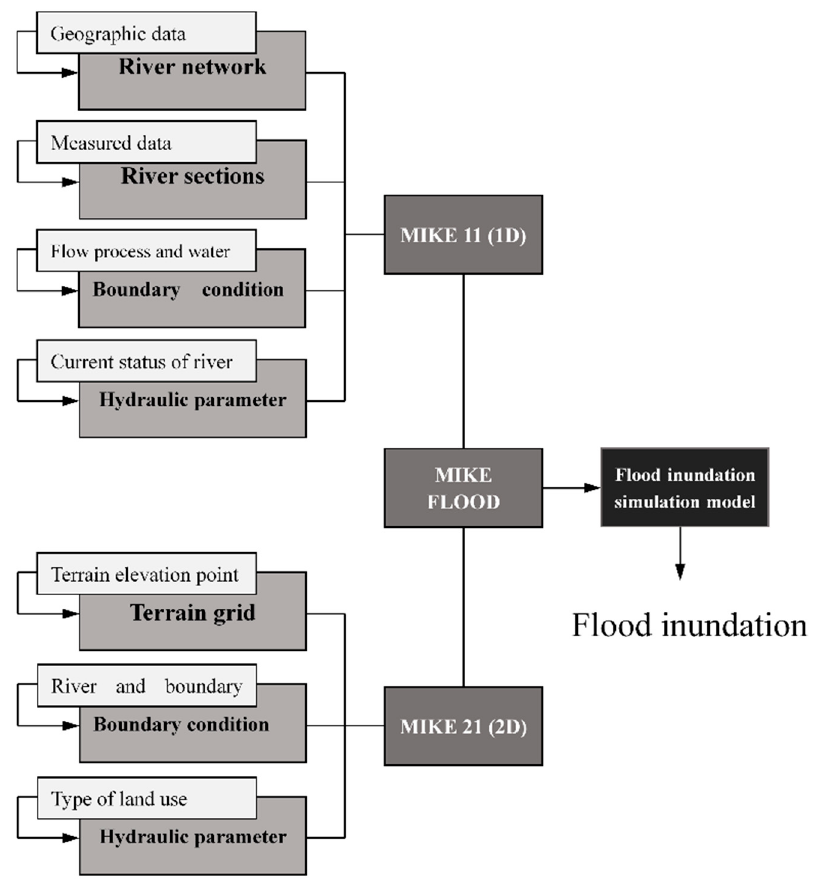
Figure 4. Flow chart of flooding simulation model.